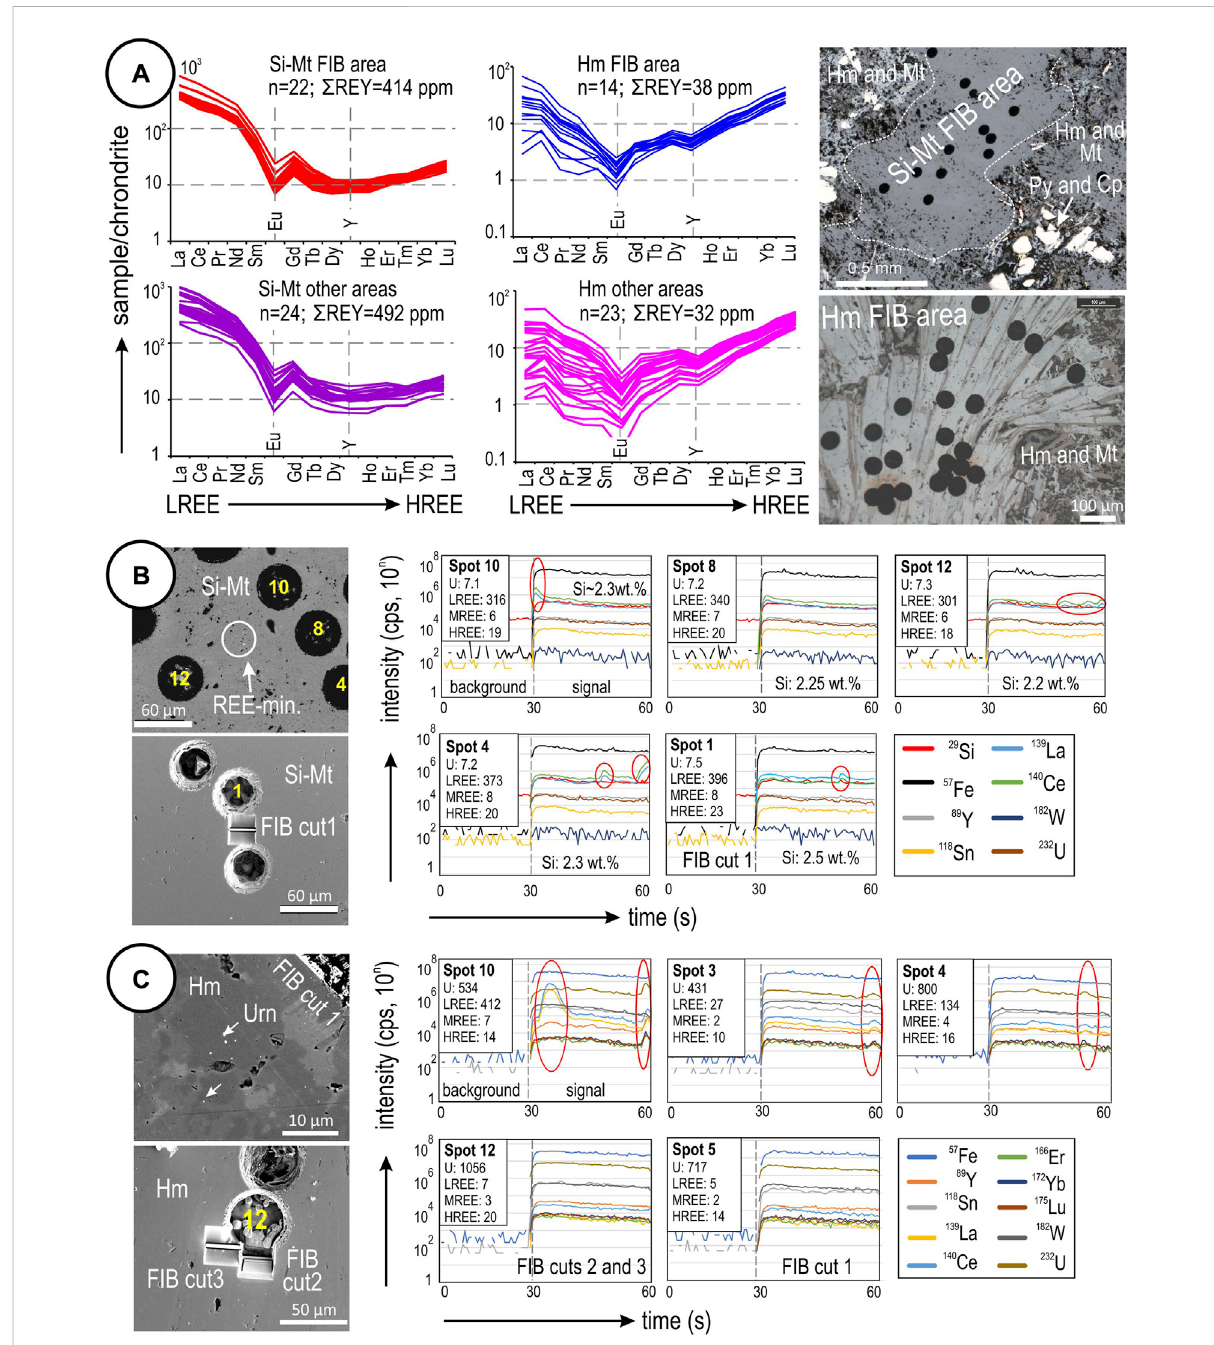
FIGURE 2 (A) REE fractionation patterns normalized to chondrite (McDonough and Sun, 1995) for silician magnetite and hematite in sample CLC21, separatedbyspotsintheimmediatevicinityofFIBcutsandthoseinotherareasofthesample.ThecomparisonshowsthattheFIB-sampledareasare representative of the greater sample with respect to REE concentrations and fractionation. Note the distinct fractionation patterns of the two Fe- oxides. (B) Selected time-resolved downhole LA-ICP-MS pro fi les for silician magnetite and BSE images of laser spots plotted. The pro fi les comprise generally fl at signals with occasional irregularities in certain elements (red circles/ovals) indicative of inclusions, notably La and Ce. (C) Selected time-resolved downhole LA-ICP-MS pro fi les for hematite. Note generally fl at signals for REEs and other elements on some pro fi les (including Spot 12, sampled by FIB) but small irregularities on signals for Spots 10, 3 and 4 (marked by red ovals) that are indicative of uraninite